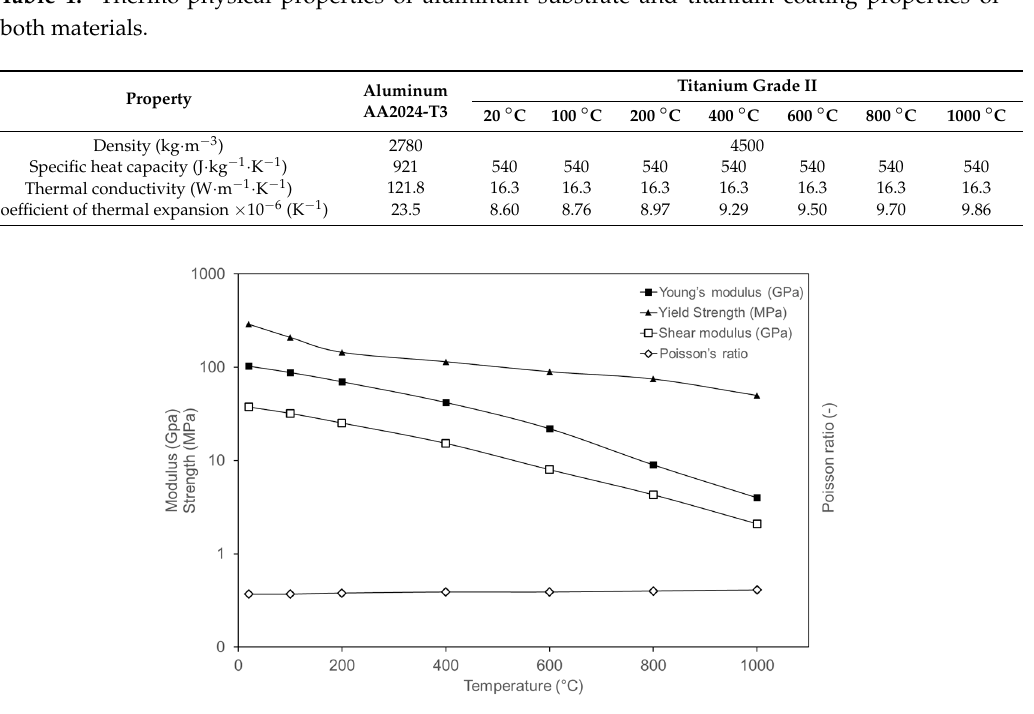
Figure 2. Temperature dependent mechanical properties of titanium coating. Table 2. Mechanical properties of Aluminum Alloy AA2024-T3.